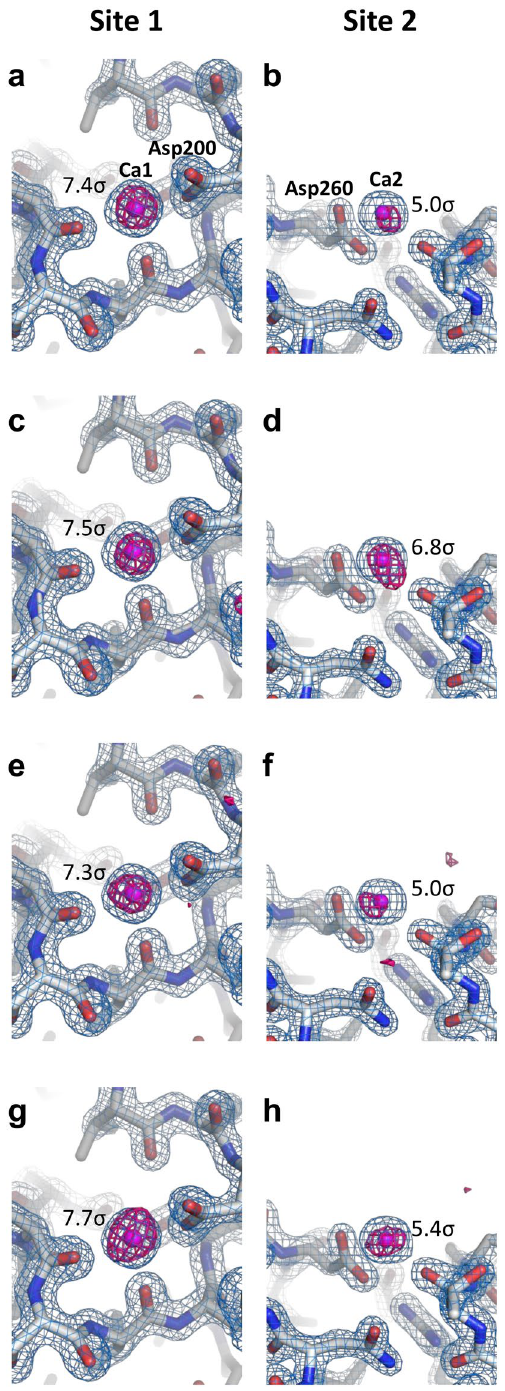
Figure 2. Electron density maps of proteinase K. Close-up views of calcium ion binding sites with 2F o –F c electron density maps contoured at the 2.0 σ level (coloured blue) for ( a , b ) paraffin grease, ( c , d ) DATPE grease, ( e , f ) nuclear grease and ( g , h ) cellulose matrices. Bound calcium ions are depicted as magenta spheres. The anomalous difference Fourier maps using 20,000 indexed images (contoured at the 3.5 σ level) are shown in red. The anomalous peak heights obtained from ANODE are displayed in figures. These figures were drawn with PyMol